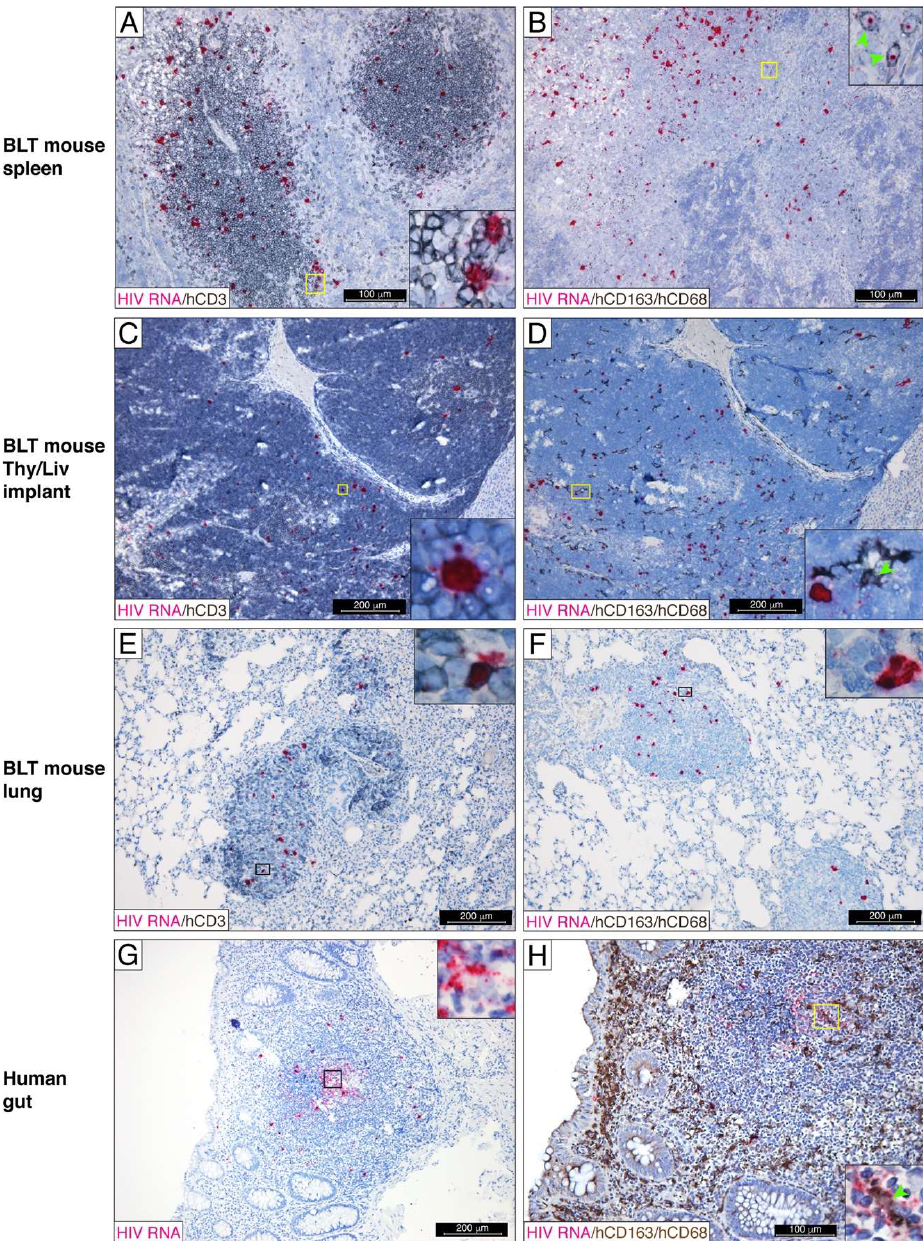
Figure 1. Tissue distribution of human HIV RNA + cells in the lymphoid compartments of HIV-viremic NSG-BLT mice. Humanized NSG-BLT mice were inoculated intraperitoneally with 25,000 TCID 50 HIV JR-CSF and euthanized 2 weeks later for tissue collection. HIV RNA was detected by RNAscope ISH using an HIV- gag-pol antisense probe in the mouse spleen ( A , B ), Thy/Liv implant ( C , D ), and mouse lung ( E , F ). Rectosigmoid biopsies from an untreated HIV-infected individual were used as a positive control for HIV detection ( G , H ). The RNAscope assay was followed by chromogenic immunohistochemistry for the human T-cell marker hCD3 ( A , C , E ) and the human macrophage markers hCD68 and hCD163 ( B , D , F , H ). Nuclei were counterstained with hematoxylin. Yellow ( A – D , H ) and black ( E – G ) oblongs indicate regions magnified in insets. The green arrowhead shows macrophages containing a single fuchsia punctum in the nucleus. The results in ( A – F ) are representative of those observed in the spleen, Thy/Liv implant, and lungs from 6 untreated HIV-inoculated NSG-BLT mice. The results in ( G ) and ( H ) are representative of those observed in rectosigmoid biopsies from 3 untreated HIV-infected